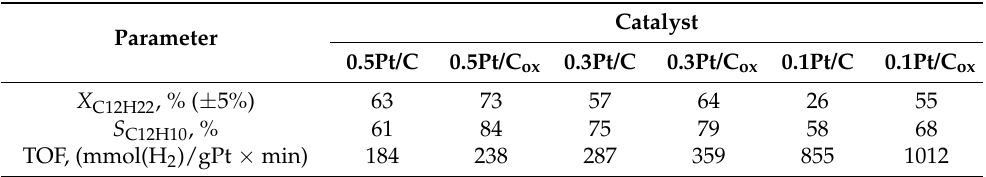
Table 3. Activity of Pt/C catalysts in the bicyclohexyl dehydrogenation reaction (T = 320 °C, p = 1 atm, VHSV = 2.8 h − 1 ).